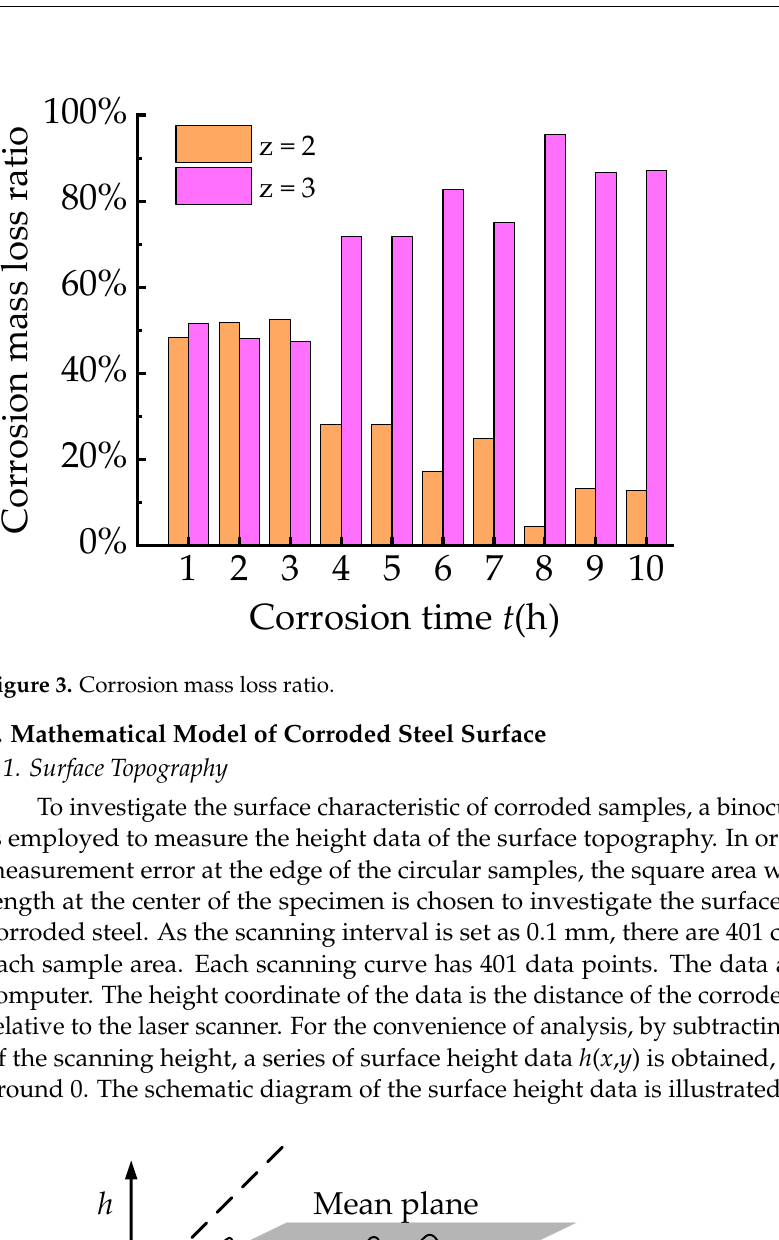
Figure 3. Corrosion mass loss ratio.